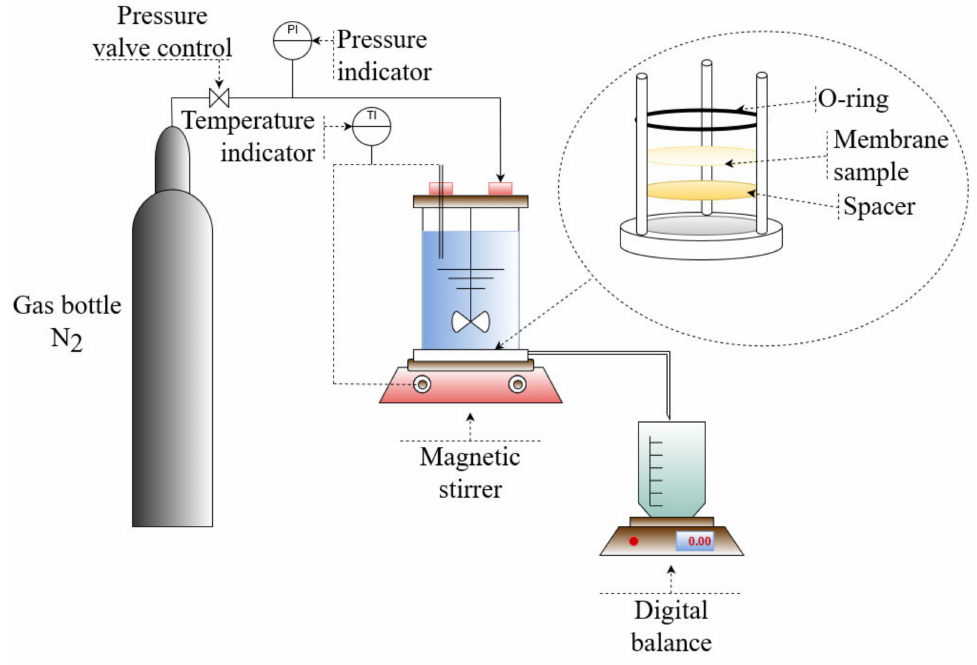
Figure 2. Schematic configuration of Amicon dead-end filtration